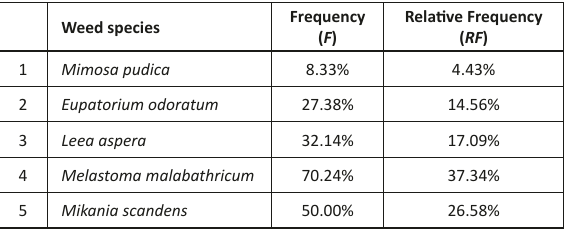
Table 2. Frequency distribution of weed species recorded in the